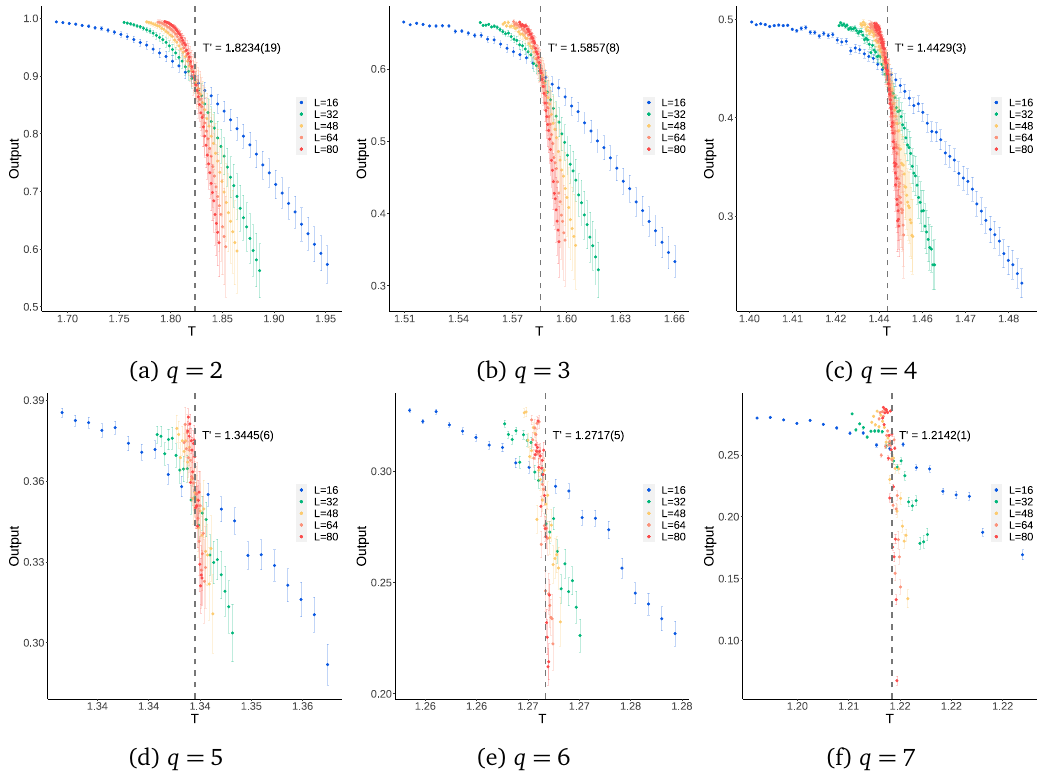
Figure 13: The relationship between temperature and the average output of an en- semble of 10 independently trained ANNs – training with simplified data, and testing with MC data of the ferromagnetic q -state Potts model on a triangular lattice. The error bars shown are 99.7% confidence intervals of the ensemble